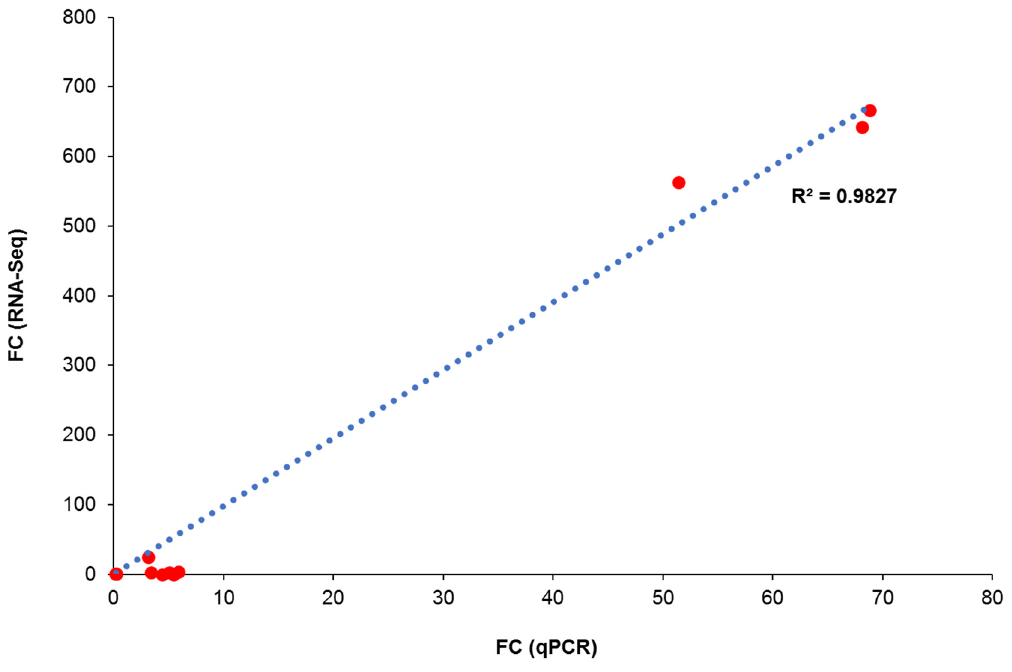
Figure 12. Correlation of FC values from qPCR and RNA sequencing for 4 target genes. Each dot represents a pair of data with FC values from respective qPCR and RNA sequencing. Abbreviations: FC, fold change, R 2 , correlation coefficient.